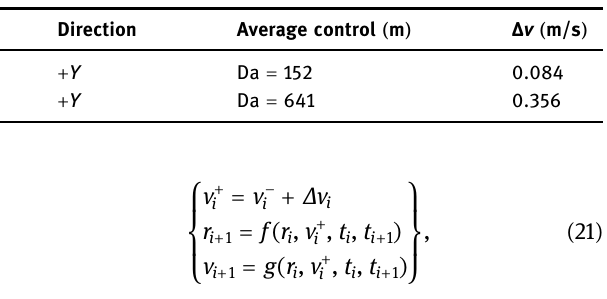
Table 2: Flight - following capture control strategy